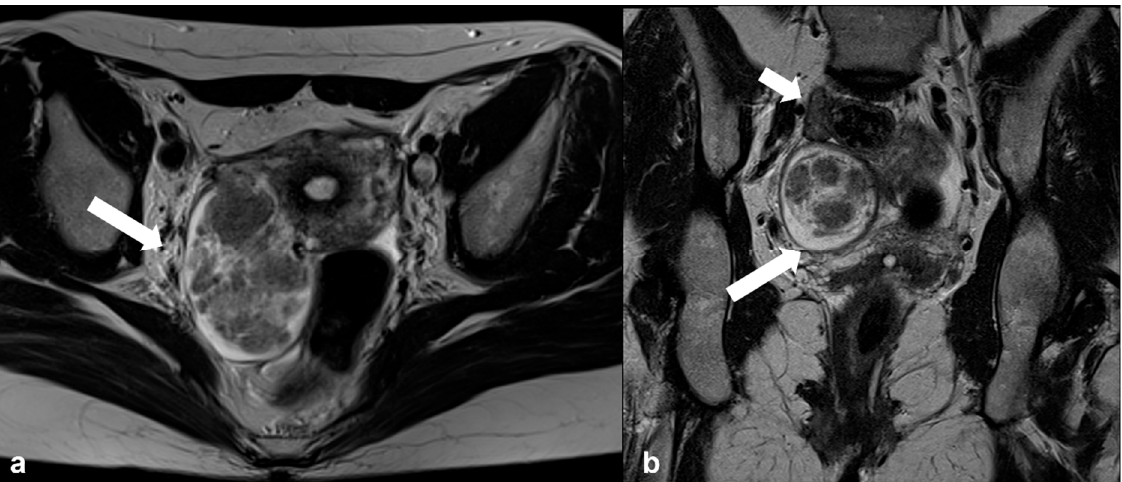
Figure 11. Degenerative pedunculated leiomyoma mimicking ovarian lesion . Axial T2 weighted image ( a ) shows a large inhomogeneous mass within the right broad ligament (arrow). Coronal oblique T2 weighted image ( b ) of the same patient shows the right ovary (short arrow) separate from the mass (long arrow).